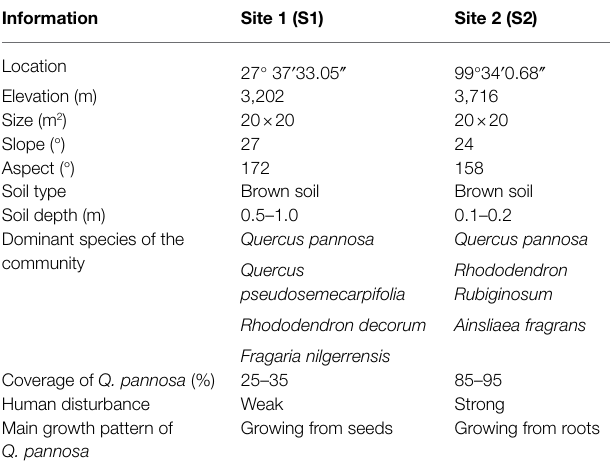
table using one quadrat of 20 m × 20 m around the center of each